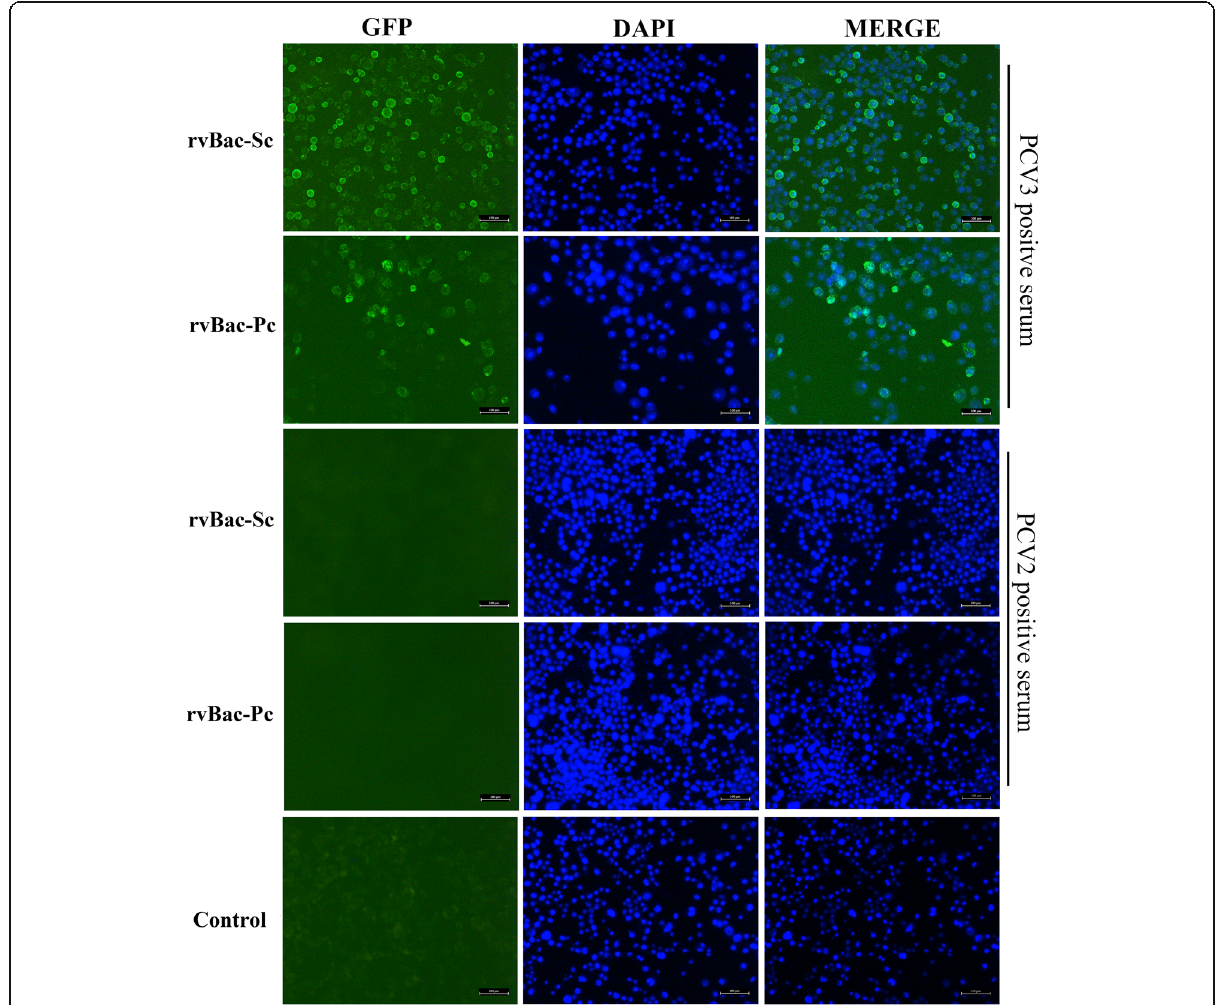
Fig. 2 Analysis of detection limitation and cross-reactivity of PCV3 Cap protein-based IFA. Fluorescence signals in different baculovirus-infected Sf9 cells when incubated with 640-fold diluted PCV3- or PCV2-positive serum